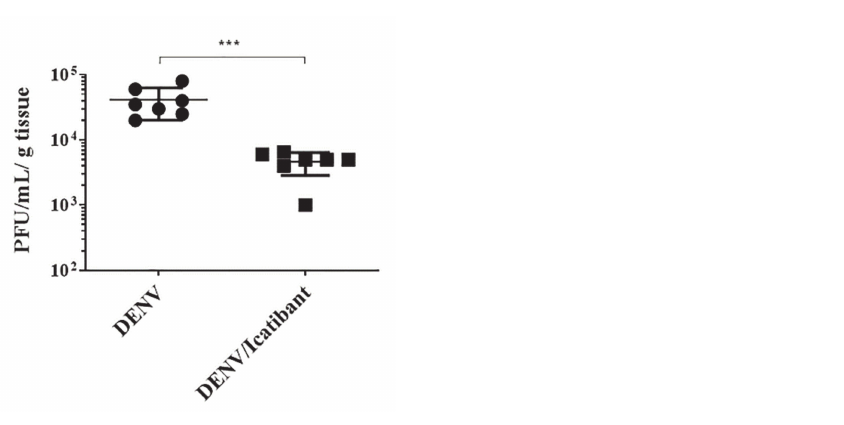
Figure 8. In vivo treatment with the B2R antagonist icatibant reduced DENV titer in the brain of wild type mice. 8-week-old Balb/c mice were infected with DENV NGC, i.c., in the presence or absence of icatibant. At 3dpi, the animals were euthanized, and the brains were harvested for viral load evaluation by conventional plaque assay. Bars represent mean ± SD and dots indicate individual mice. *** p ≤